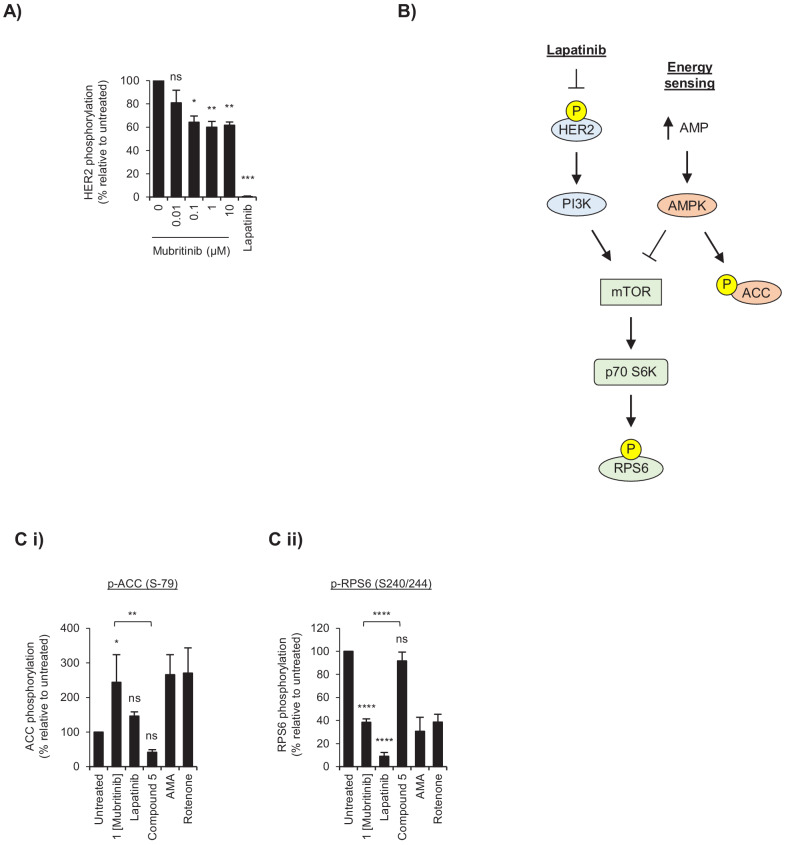
Mubritinib targets complex I in cardiomyocytes.(A) Quantification of HER2 phosphorylation from Figure 1A displayed relative to the untreated sample. Error bars represent standard deviation (n = 3) and significance was assessed using unpaired students t-test (****p<0.0001, **p<0.01, *p<0.05, ns = not significant). (B) Schematic to show the key components in the signalling pathway that is downstream from changes in energy status or inhibition of HER2. Arrows indicate activation and blocked arrows indicate inactivation of the downstream target. (C) Quantification of (i) ACC (S-79) and (ii) RPS6 (S-240/244) phosphorylation from Figure 1B displayed relative to the untreated sample. Error bars represent standard deviation (n = 3) and significance was assessed using the unpaired students t-test (*p<0.05, **p<0.01, ***p<0.001, ns = not significant).